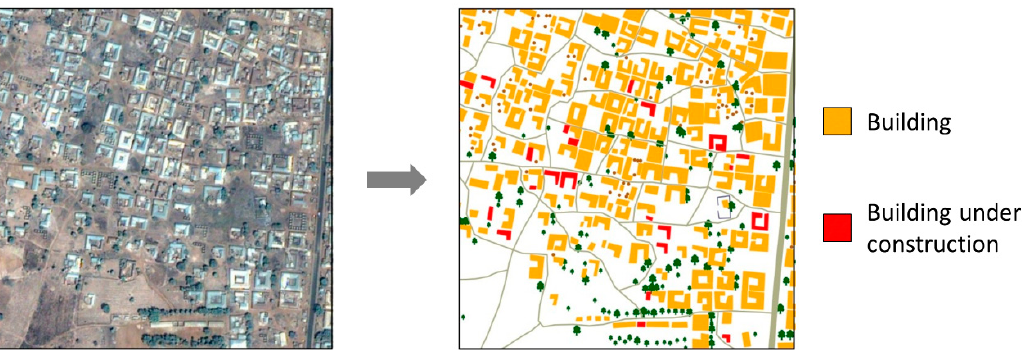
Figure 4. Digitised buildings based on Google Earth imagery (source: Google Earth, 2014). Note: Buildings under construction were not included in the land use change analysis.